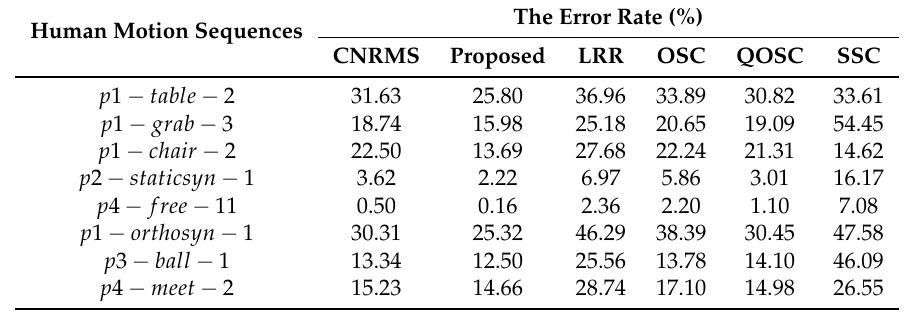
Table 6. The NMI for 8 sequences { “ p 1 − table − 2”,“ p 1 − grab − 3”,“ p 1 − chair − 2”,“ p 2 − staticsyn